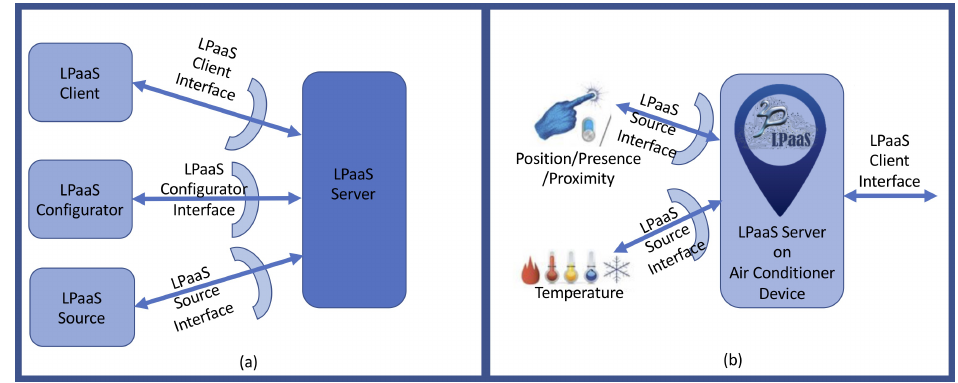
Figure 2. The LPaaS actors and their interfaces ( a ). An example of the use of the source interface ( b